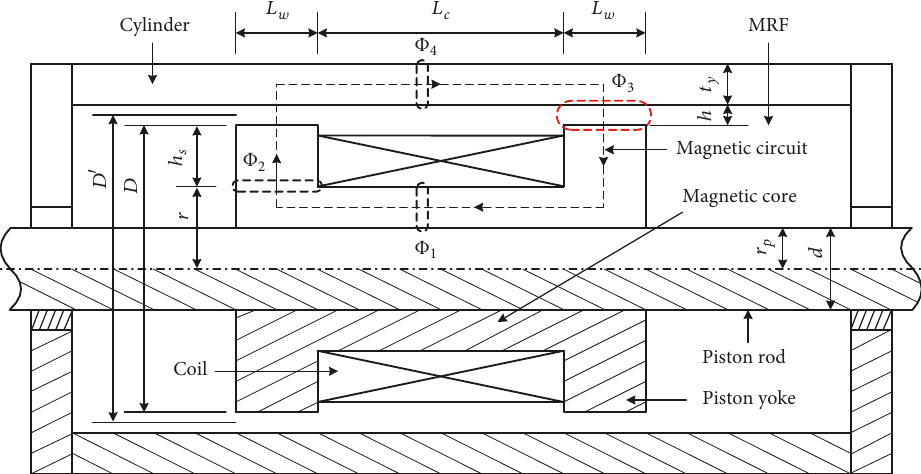
Figure 3: Schematic of shear-valve mode MRF